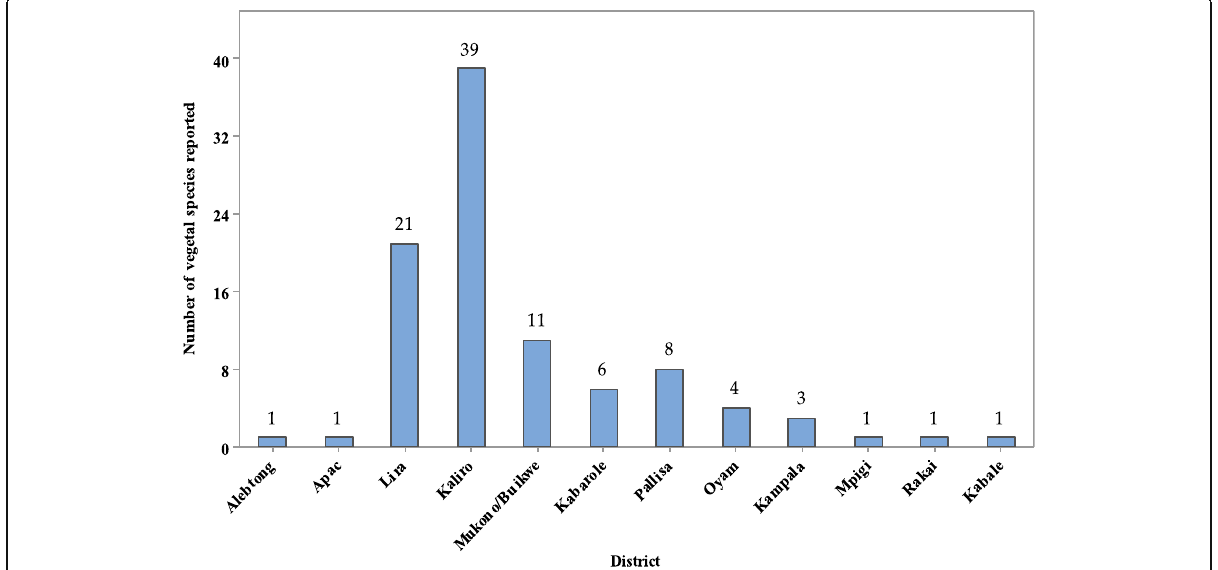
Fig. 3 Distribution of antivenin plant species in Ugandan districts as per ethnobotanical